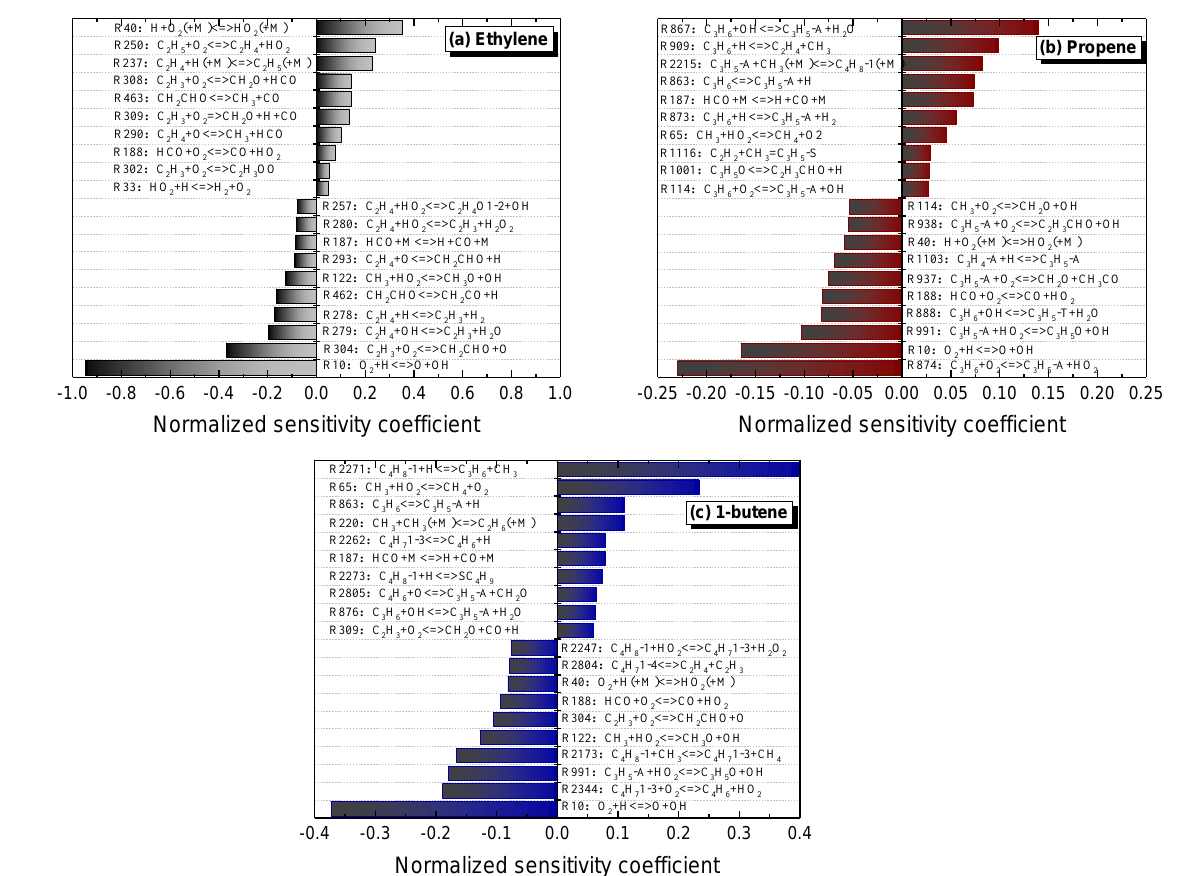
Figure 19. Normalized sensitivity coefficients of C 2 –C 4 1-alkanes at 16.0 atm and 1250 K. ( a ) ethylene; ( b ) propene; ( c ) 1-butene.